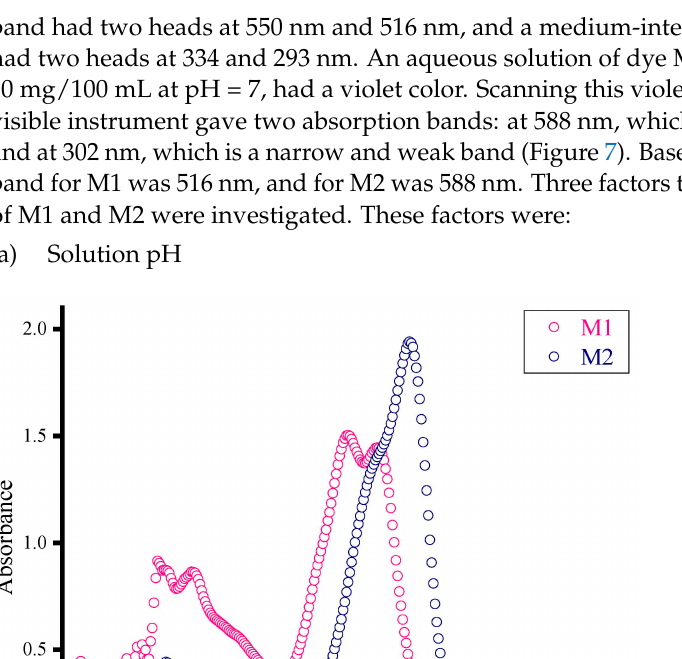
Figure 7. The UV-Vis spectra of M1 and M2 in aqueous solution (10 mg/100 mL) at pH = 7.